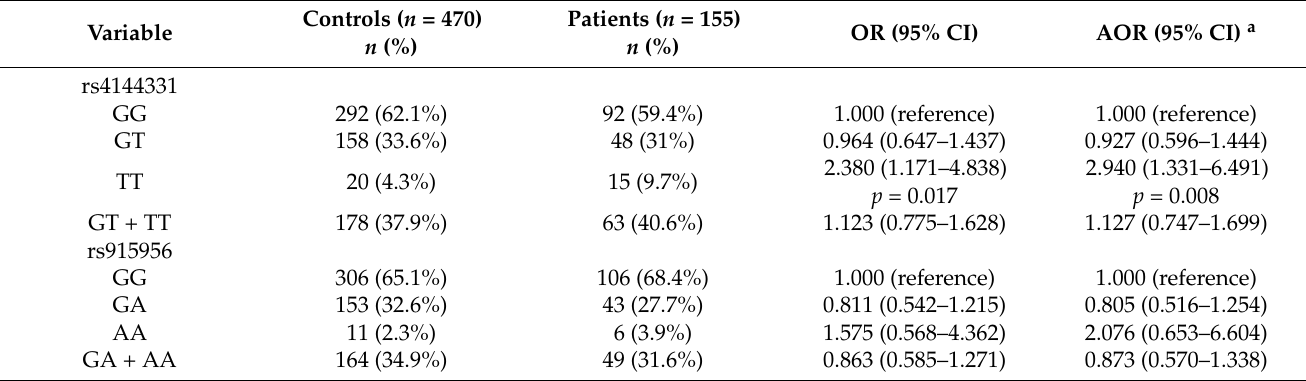
Table 4. Genotyping and allele frequency of TRIM-21 single nucleotide polymorphism (SNP) in HCC and normal controls smokers.